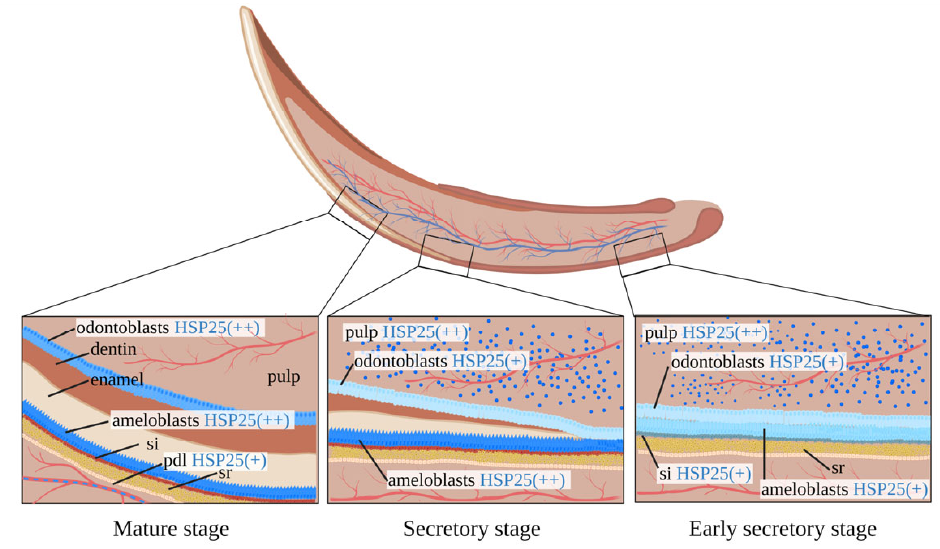
Figure 3. HSP25 in PN30 mouse incisors. From the early secretory stage to the mature stage, odontoblasts and ameloblasts gradually matured. Additionally, the secretory activity increased. Thus, the expression of HSP25 increased gradually. However, the expression of HSP25 in dental pulp decreased gradually. Additionally, the stratum intermedium shows a mild expression of HSP25 during the early secretory stage. Blood vessels in the periodontal ligament also express HSP25 mildly during the mature stage. pdl: periodontal ligament; si: stratum intermedium; sr: stellate reticulum. (+): mild; (++): strong. Figures created with BioRender.com, accessed on 23 May 2022.